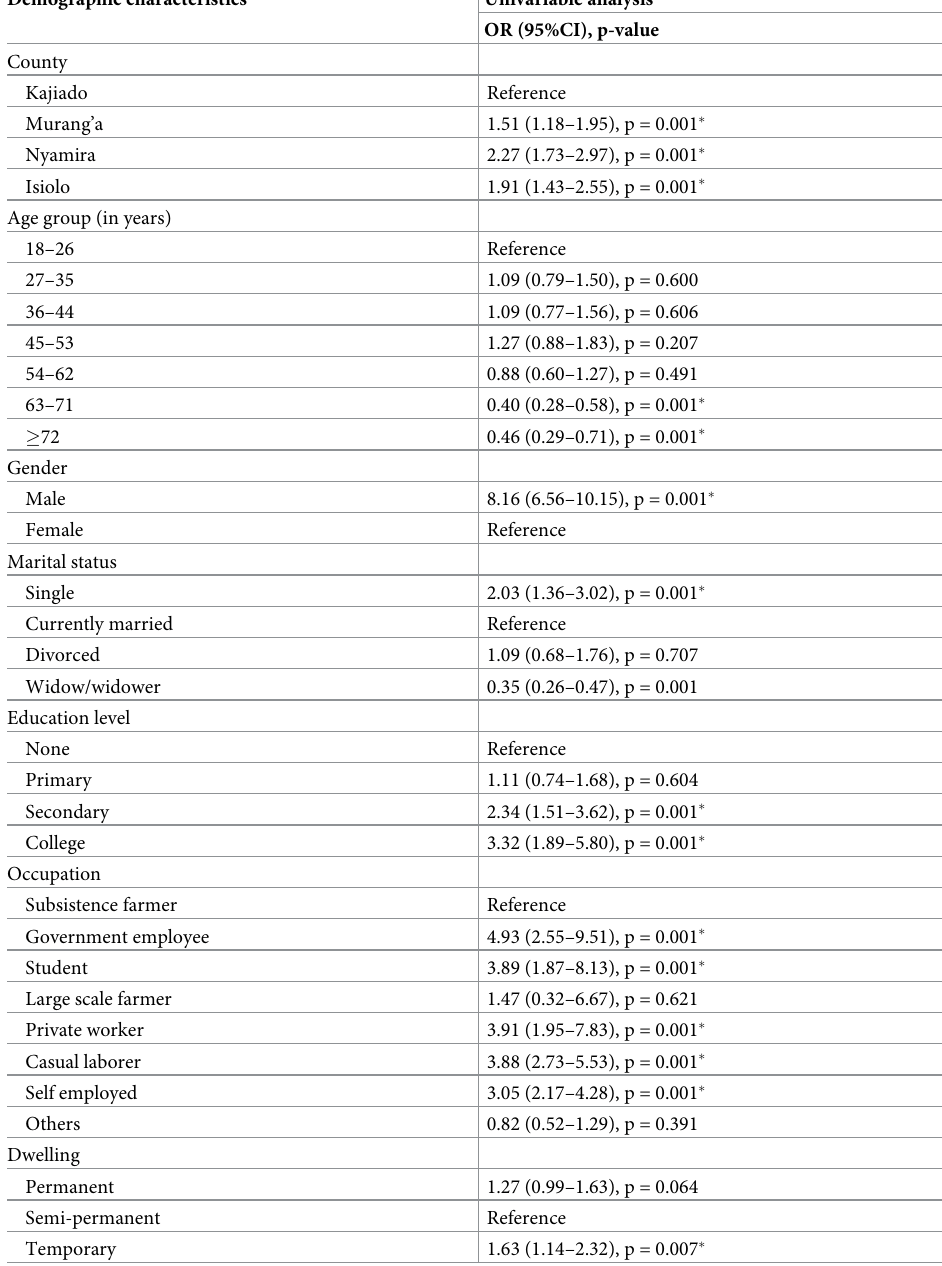
Table 4. Univariable analysis of risk factors associated with any type of drugs and substances in Kenya. Demographic